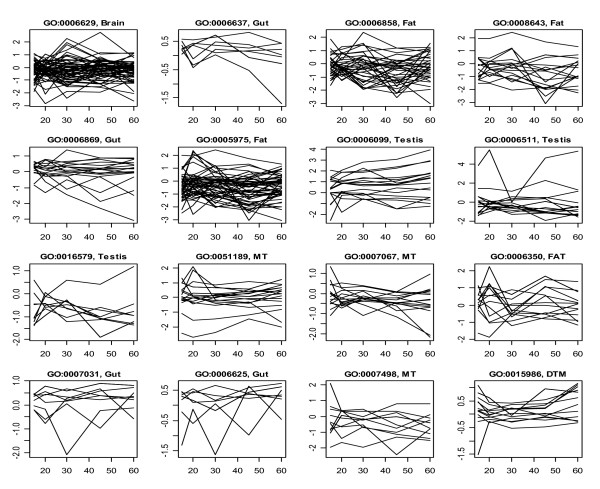
Transcriptional profiles of genes involved in 16 GO biological processes predictable with term-tissue specific models. The plot names indicate the IDs of the GO terms and the tissues from which the top prediction models were generated, and the plots were based on the averages of the duplicated measurements at each age points for the corresponding tissues. MT and DTM represent malpighian tubule, and dorsal thoracic muscle, respectively.